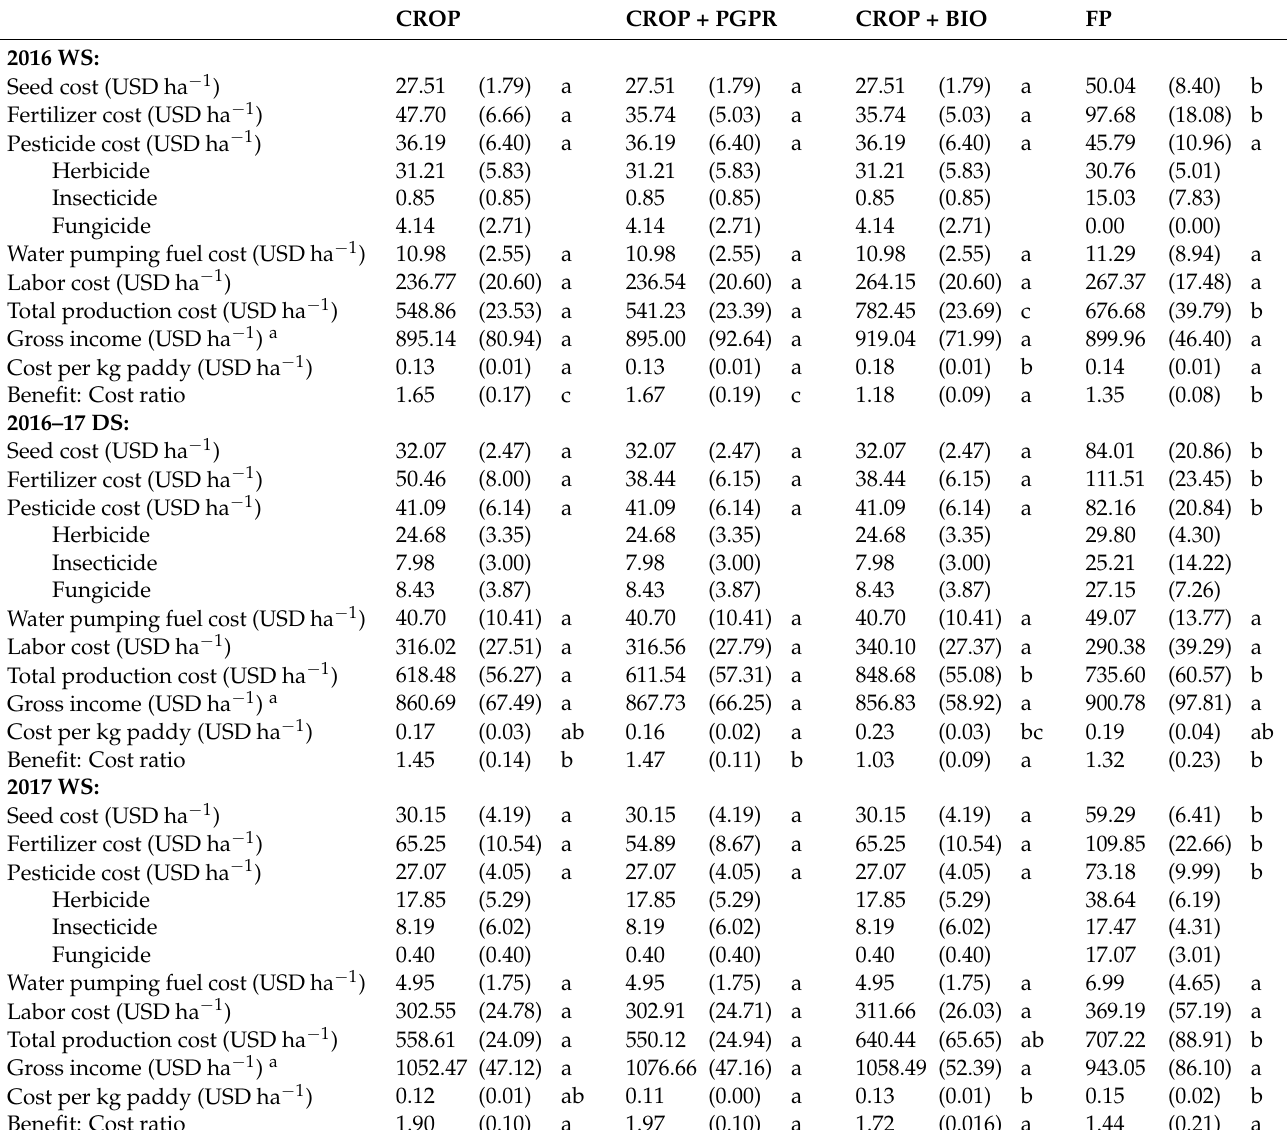
Table 4. Economic analysis (mean values followed by standard error in parenthesis) of rice production across four field trial treatments over three